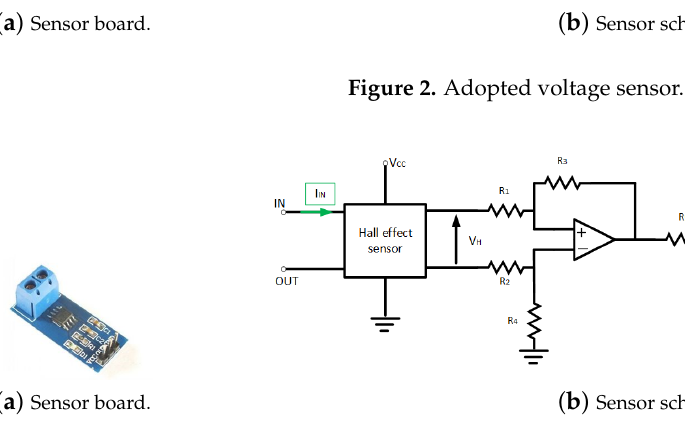
Figure 3. Adopted current